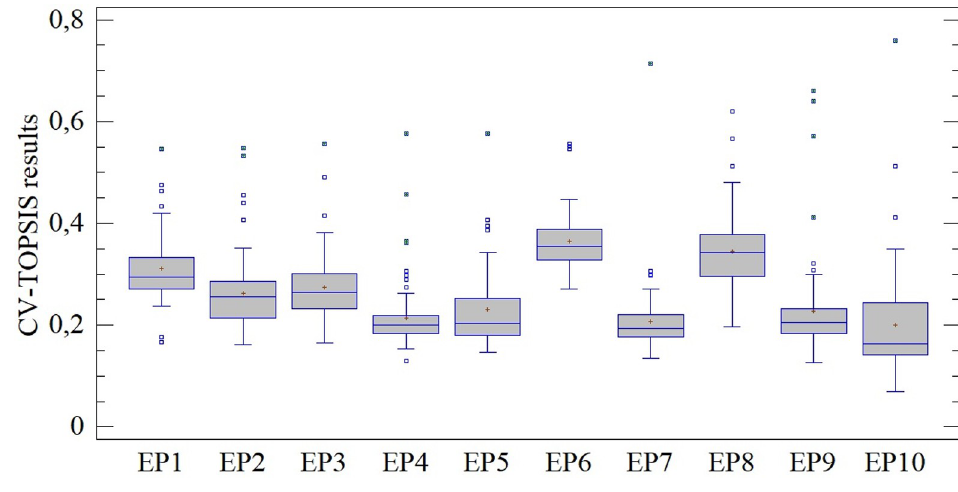
Fig 4. Results of assessment using the CV-TOPSIS method.